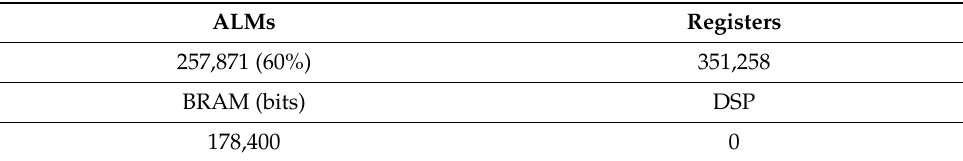
Table 5. The resource utilization of the PermLSTM accelerator.